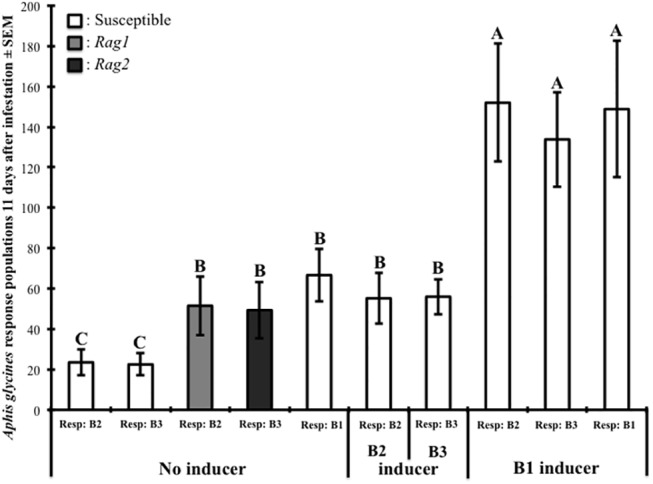
Addition of an inducer population affects subsequent fitness of virulent biotypes on a susceptible cultivar.This effect was observed by varying inducer population biotypes on varying response population biotypes on susceptible soybean. For this experiment the susceptible cultivar IA3027, Rag1 cultivar IA3027RA1, and Rag2 cultivar IA3027RA2 were used. Capital letters indicate significance among treatments (P < 0.05).